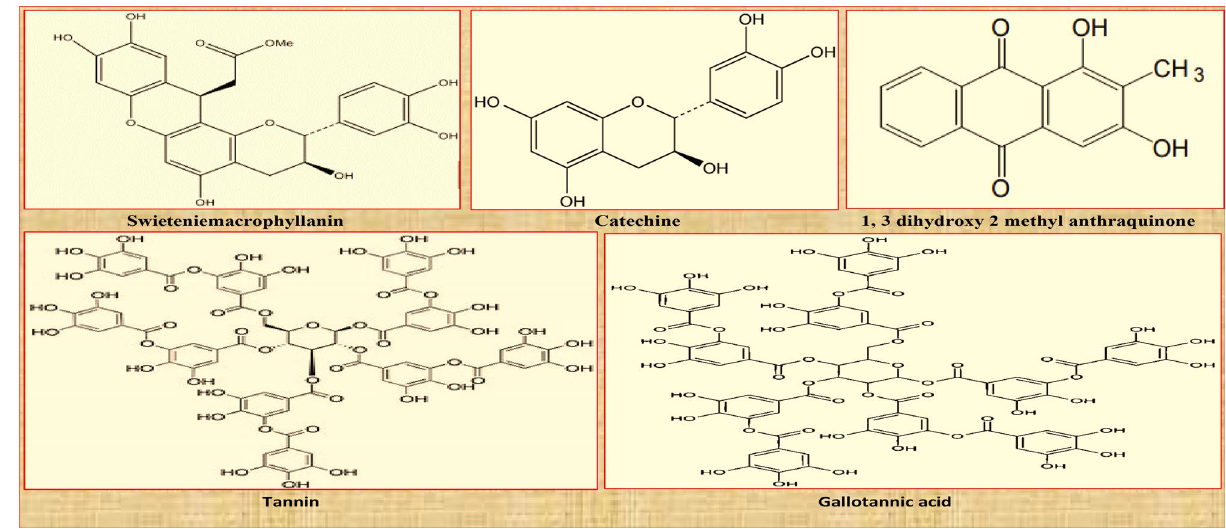
Figure 9. Phytochemicals of NPND materials responsible for camouflage coloration against woodland CB, Shorea Robusta